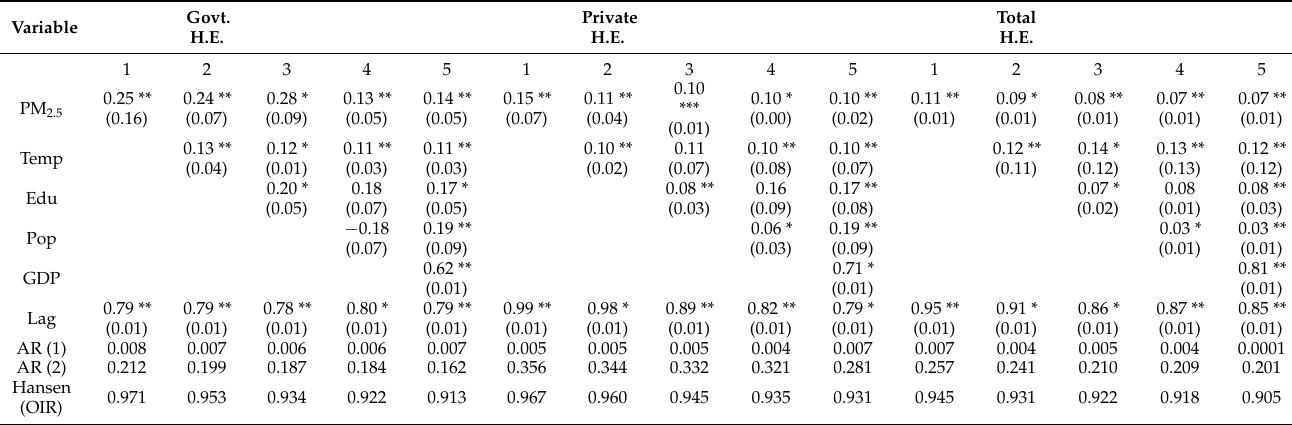
Table 4. Results (System